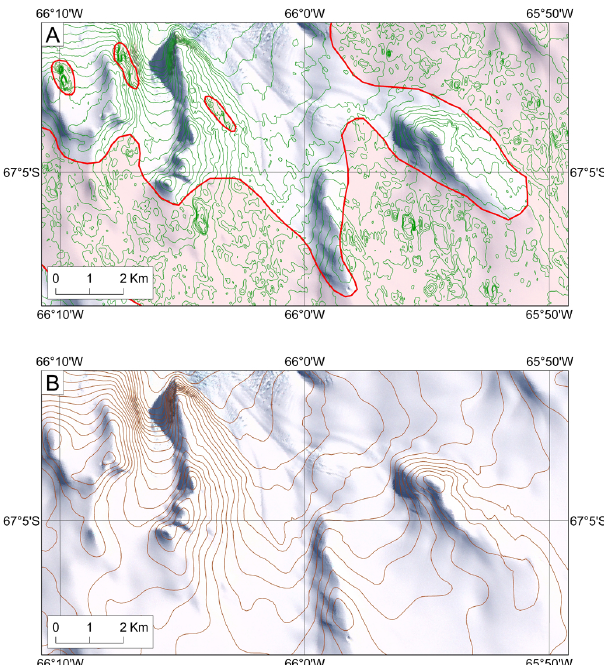
Figure 3. Sample area displaying 50m contours generated from raw ASTER GDEM and error-region polygons (in pink) (A) . This illustrates the first stage of the methodology: delineation of erro- neous regions using contours draped over LIMA as a guide. The end-product has been contoured to illustrate the improvement in the DEM from the original and also the consistency of the topography at error region boundaries (B)